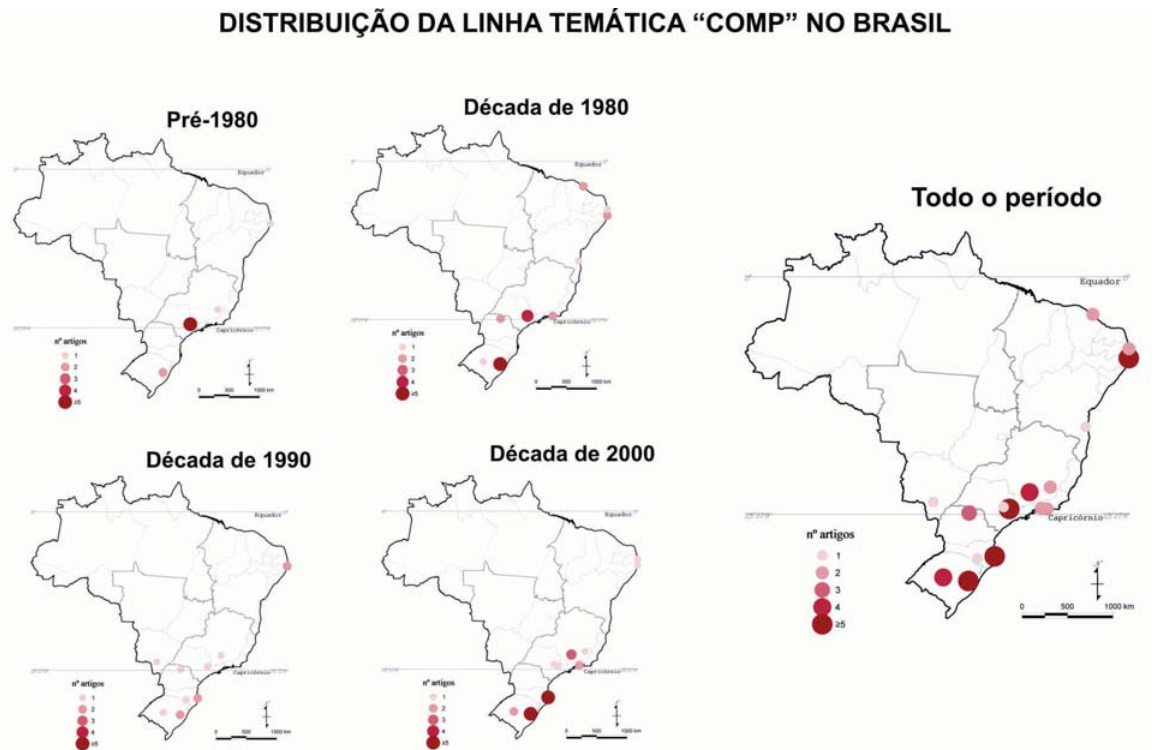
década.Figura 3. Distribuição espacial da produção de artigos na linha temática “COMP” (comparação de manejos) por